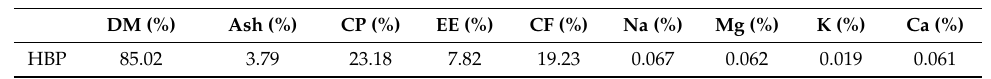
Table 2. Chemical composition of honey bee